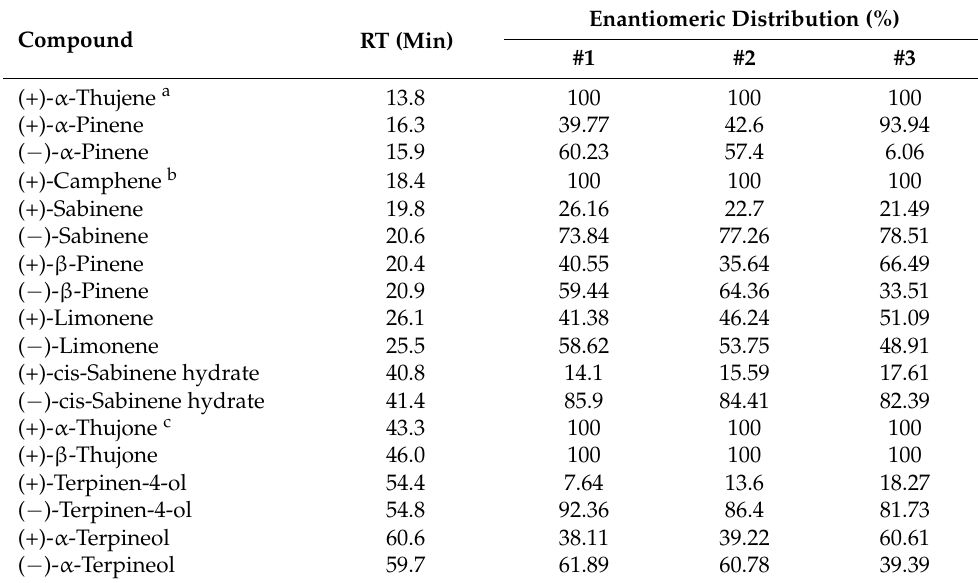
Table 2. Enantiomeric distribution of monoterpenoid components in Boswellia ogadensis resin essential oils.